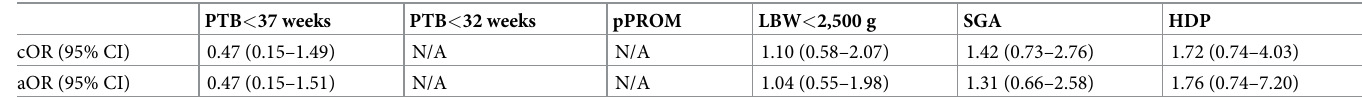
Table 4. Effect of CT infection on pregnancy outcomes (Fukushima